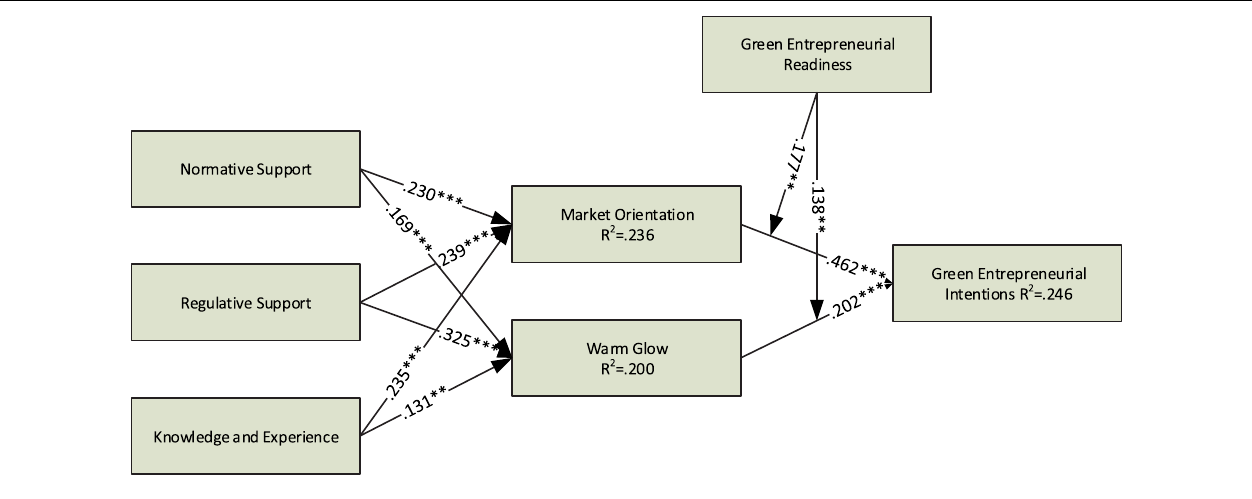
FIGURE 1 | Graphical explanation of the model examined. *** = Significance level of 0.001, ** = Significance level of 0.01.